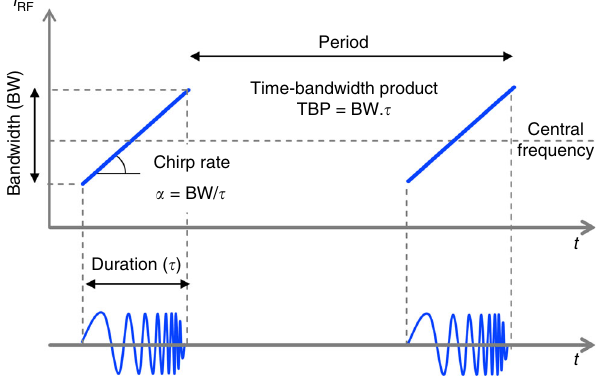
Fig. 1 Schematic illustration of periodic linear RFCWs in the time — radio- frequency plane. Mathematically, an individual linear chirp can be described as the product between a slowly varying envelope function multiplied by a complex factor e i πα t 2 , where α is called the chirp